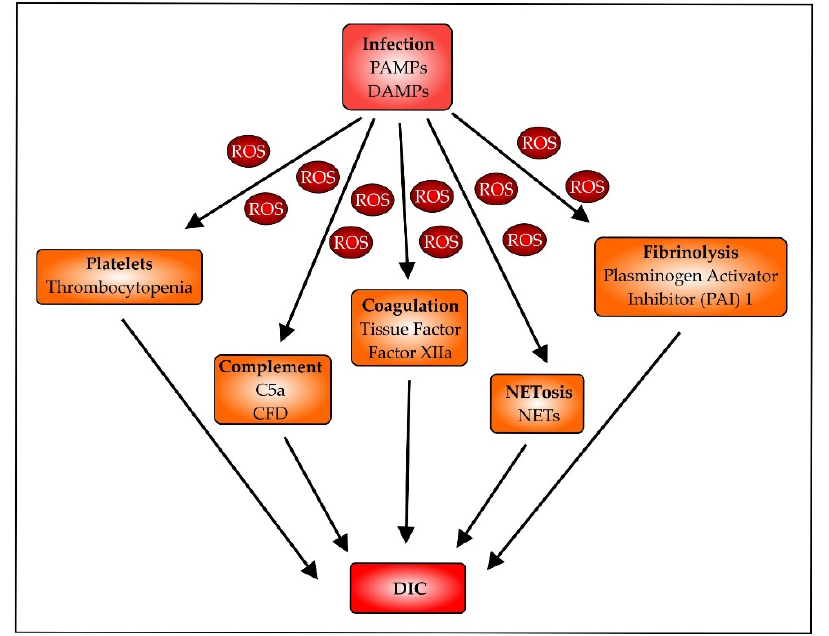
Figure 5. Disseminated intravascular coagulation (DIC). Infectious pathogens via their associated PAMPs release resultant DAMPs, following cell activation or damage, leading to ROS production.